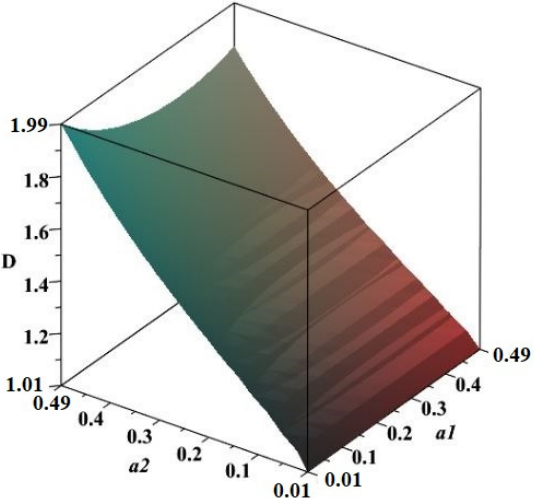
Figure 2. The 3D graphical representation of the fractal dimension D , depending on the variables a 1 and a 2.